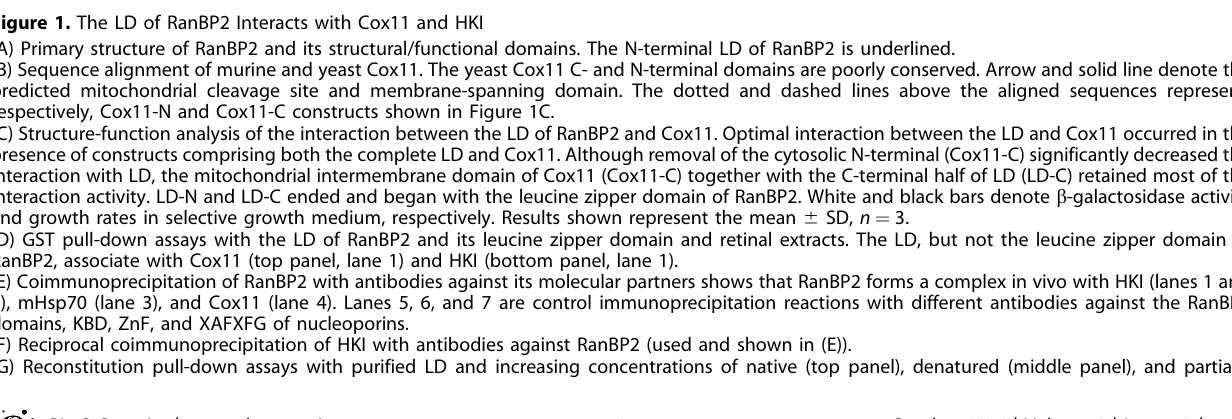
Figure 1. The LD of RanBP2 Interacts with Cox11 and HKI (A) Primary structure of RanBP2 and its structural/functional domains. The N-terminal LD of RanBP2 is underlined. (B) Sequence alignment of murine and yeast Cox11. The yeast Cox11 C- and N-terminal domains are poorly conserved. Arrow and solid line denote the predicted mitochondrial cleavage site and membrane-spanning domain. The dotted and dashed lines above the aligned sequences represent, respectively, Cox11-N and Cox11-C constructs shown in Figure 1C. (C) Structure-function analysis of the interaction between the LD of RanBP2 and Cox11. Optimal interaction between the LD and Cox11 occurred in the presence of constructs comprising both the complete LD and Cox11. Although removal of the cytosolic N-terminal (Cox11-C) significantly decreased the interaction with LD, the mitochondrial intermembrane domain of Cox11 (Cox11-C) together with the C-terminal half of LD (LD-C) retained most of the interaction activity. LD-N and LD-C ended and began with the leucine zipper domain of RanBP2. White and black bars denote b -galactosidase activity and growth rates in selective growth medium, respectively. Results shown represent the mean 6 SD, n ¼ 3. (D) GST pull-down assays with the LD of RanBP2 and its leucine zipper domain and retinal extracts. The LD, but not the leucine zipper domain of RanBP2, associate with Cox11 (top panel, lane 1) and HKI (bottom panel, lane 1). (E) Coimmunoprecipitation of RanBP2 with antibodies against its molecular partners shows that RanBP2 forms a complex in vivo with HKI (lanes 1 and 2), mHsp70 (lane 3), and Cox11 (lane 4). Lanes 5, 6, and 7 are control immunoprecipitation reactions with different antibodies against the RanBP2 domains, KBD, ZnF, and XAFXFG of nucleoporins. (F) Reciprocal coimmunoprecipitation of HKI with antibodies against RanBP2 (used and shown in (E)). (G) Reconstitution pull-down assays with purified LD and increasing concentrations of native (top panel), denatured (middle panel), and partially PLoS Genetics |